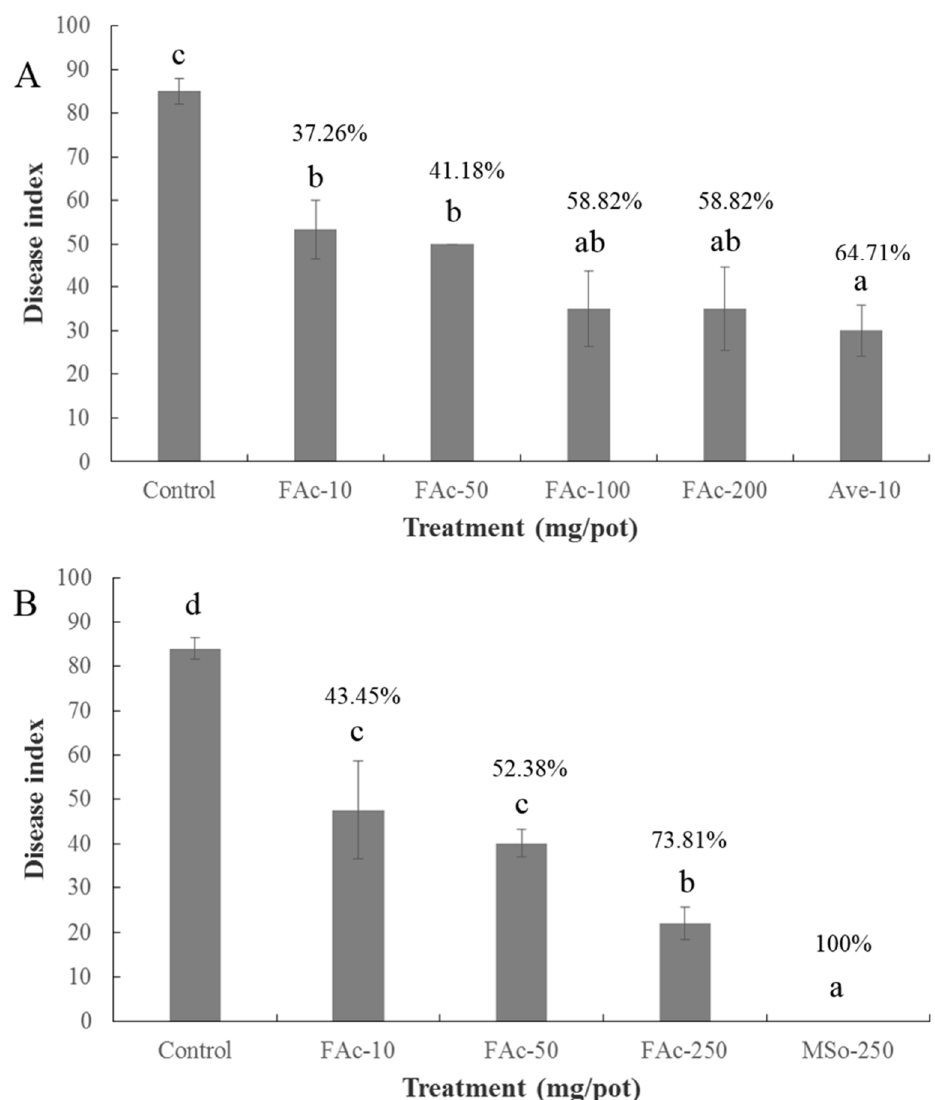
Figure 3. Control efficiency of FAc, avermectin (Ave), and metam sodium (MSo) on RKNs in pots. ( A ) Chemicals were irrigated into the rhizosphere of the plant. ( B ) chemicals were applied as fumigants. Data are shown as mean ± standard error ( n = 5), and different lowercase letters indicate significant difference among treatments by LSD test ( p < 0.05). The numbers above the lowercase letters indicate the control effect of each group compared with the control.